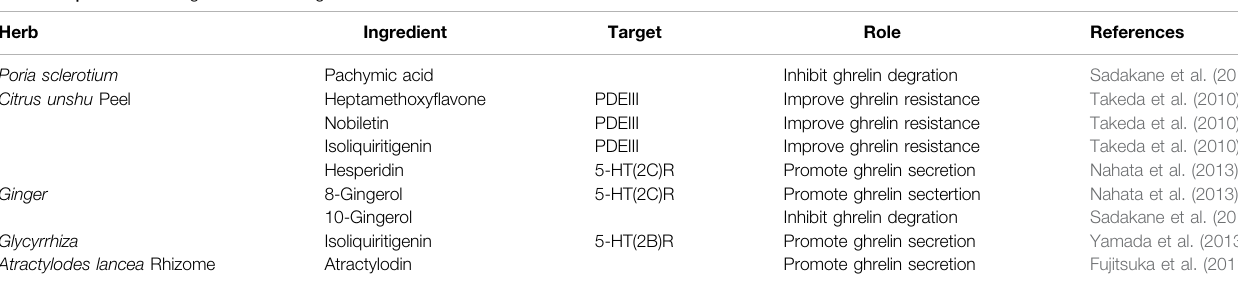
TABLE 2 | Rikkunshito ingredients with a ghrelin-related effect.